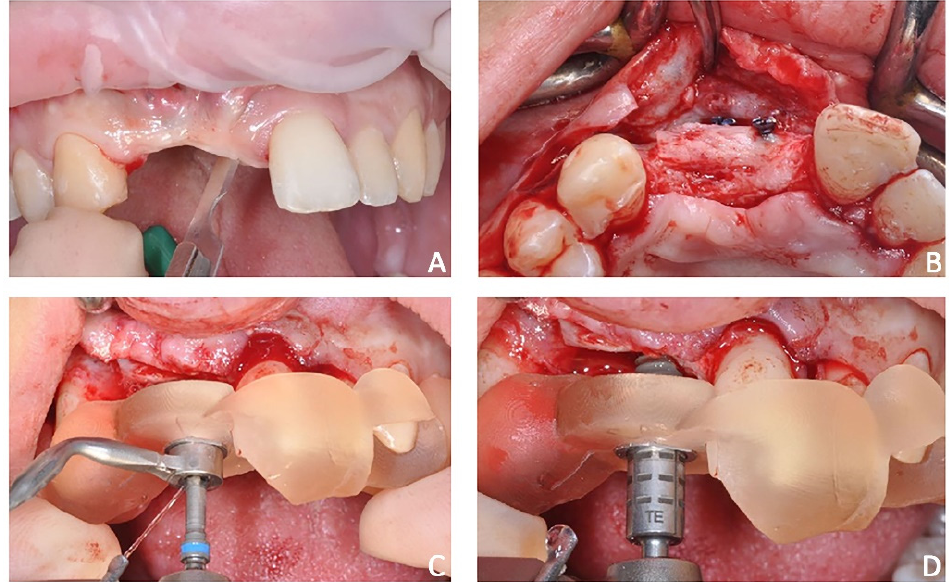
Figure 10. Case 2. Clinical procedure of the guided implant surgery. ( A ) flap incision, ( B ) flap elevation, ( C ) placement of surgical guide, and ( D ) guided implant placement.